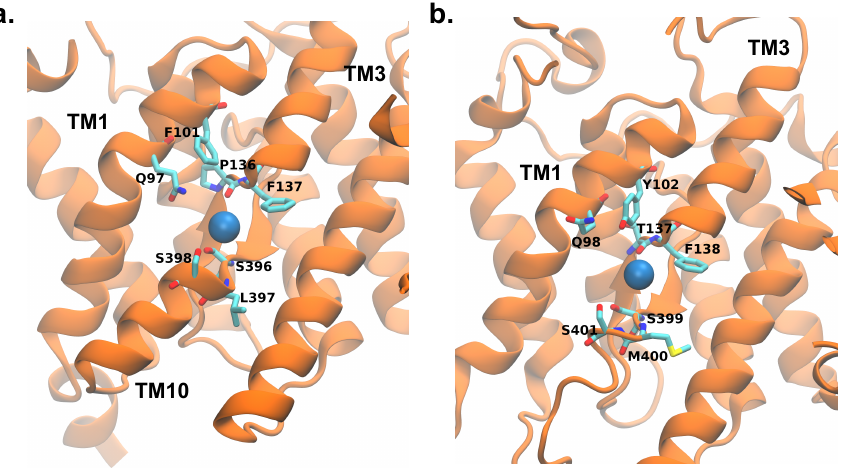
Figure 9. Binding of chloride ions as occurred during the simulation with applied electric field in rI ( a ) and zI ( b ). The highlighted residues are the functional amino acids identified in the work by Walter et al.